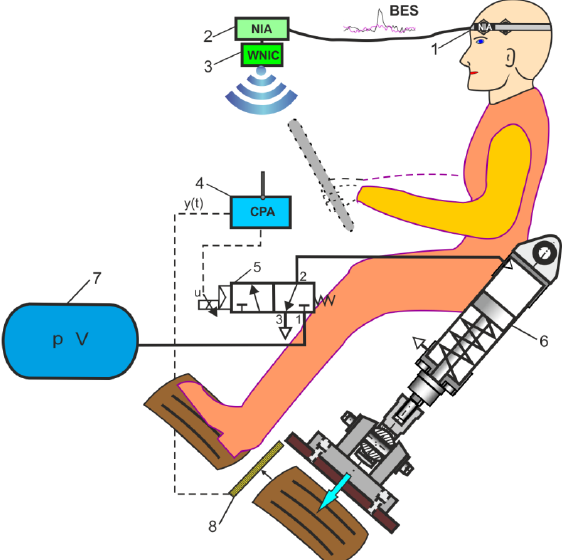
Figure 4. Diagram of the test bench for testing a pneumatically actuated secondary foot brake pedal: